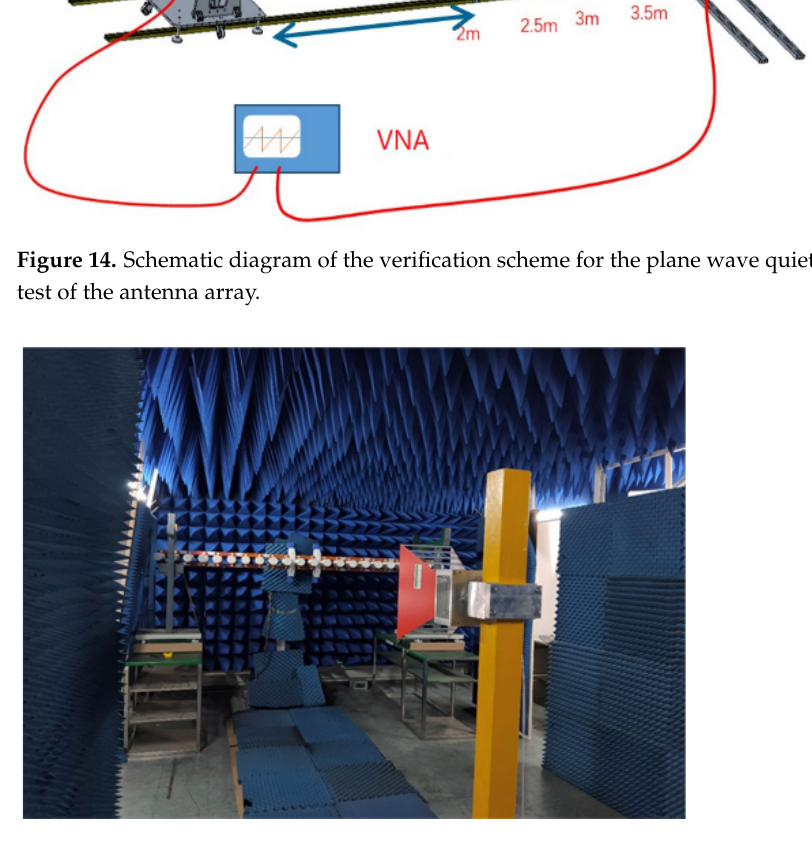
Figure 15. Test and verification of antenna array plane wave synthesis performance. The performance validation results of the PWG’s plane wave synthesis in the target area are shown in Table 2. In the frequency range from 700 MHz to 2.0 GHz, the amplitude distribution fluctuations at most positions were between 1.0 and 1.35 dB, with the maximum value being 1.48 dB. The phase distribution fluctuations were between 10 and 13 ◦ , and the maximum value was 15.3 ◦ . In the frequency range from 2.0 GHz to 3.0 GHz, the amplitude distribution fluctuations at most positions were between 0.91 and 1.5 dB,